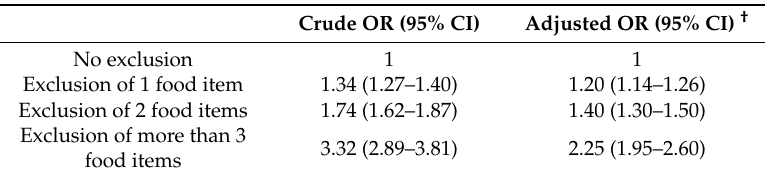
Table 4. Odds-Ratios (95% confidence interval) for the association of the number of excluded food items with depressive